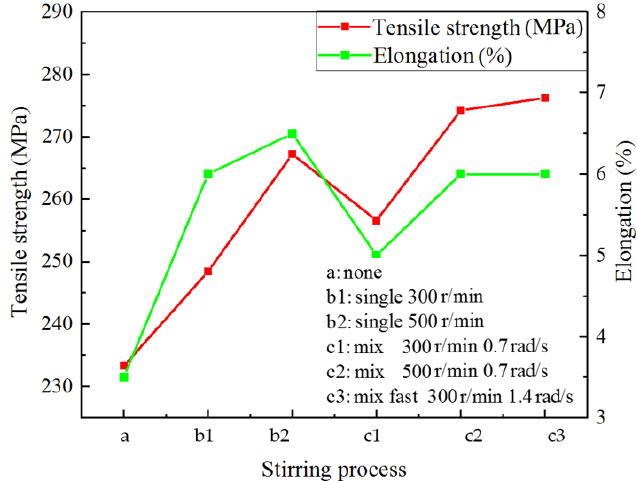
Figure 8. Mechanical properties of A356 semi-solid alloy under different stirring processes.